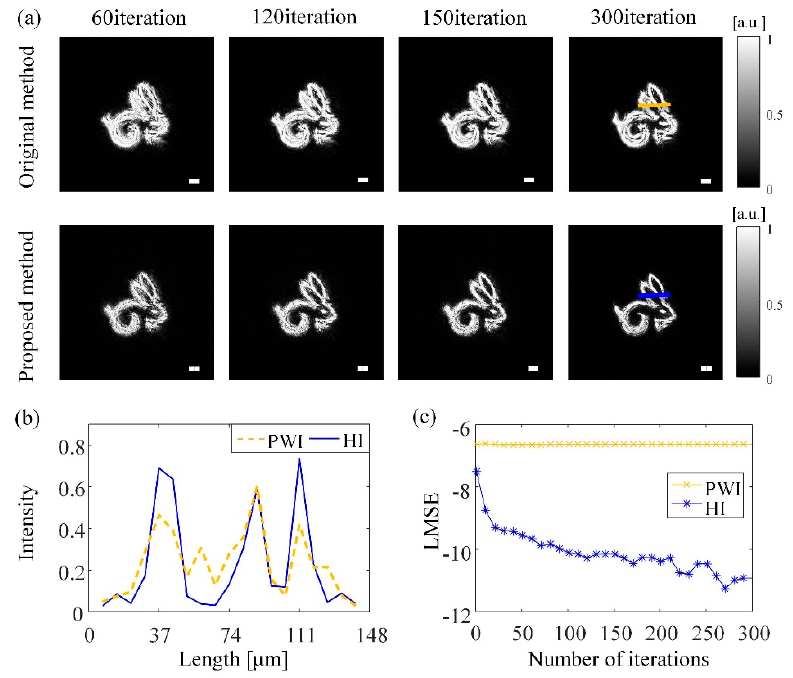
Figure 9. The reconstruction results of a designed pattern “rabbit”. ( a ) The reconstructed amplitude images using original and proposed method after 60, 120, 150, and 300 iterations, respectively. ( b ) The intensity contrast of the marked lines in ( a ). ( c ) LMSE curves for an increasing number of iterations. The white bars in ( a ) indicate the length of 200 μ m.